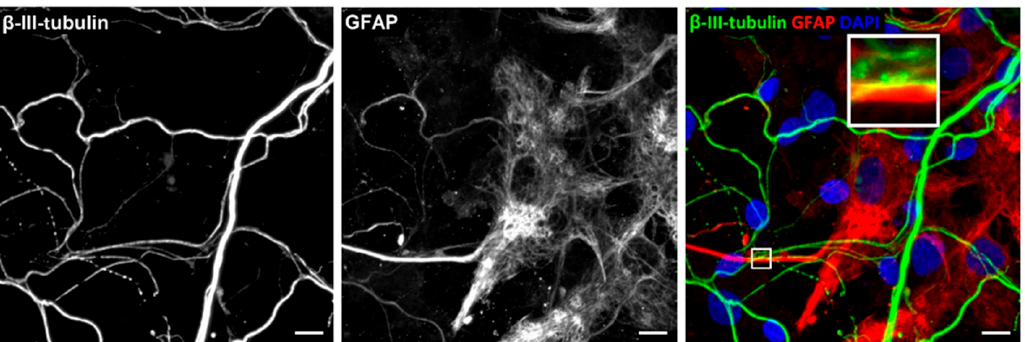
Figure 3. Interaction between neuronal axons and non-myelinating Schwann cells at Day 14. Image is representative of neuronal cells in the co-culture stained for β -III-Tubulin (green), Schwann cells stained for glial fibrillary acidic protein (GFAP) (red) and DAPI (blue). Enlarged Inset shows cellular interaction. Scale bar = 10 µm.